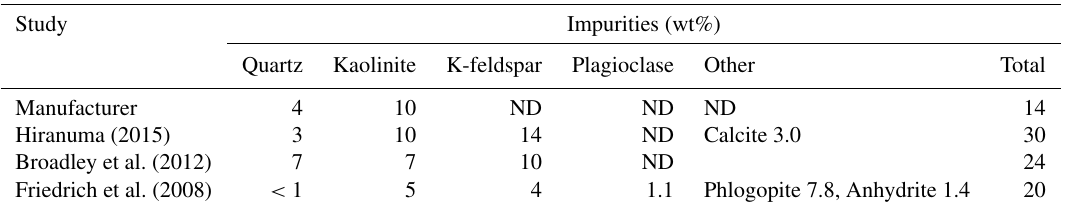
Table 4. Minerological impurities in illite NX as determined by X-ray diffraction. ND stands for not detected.